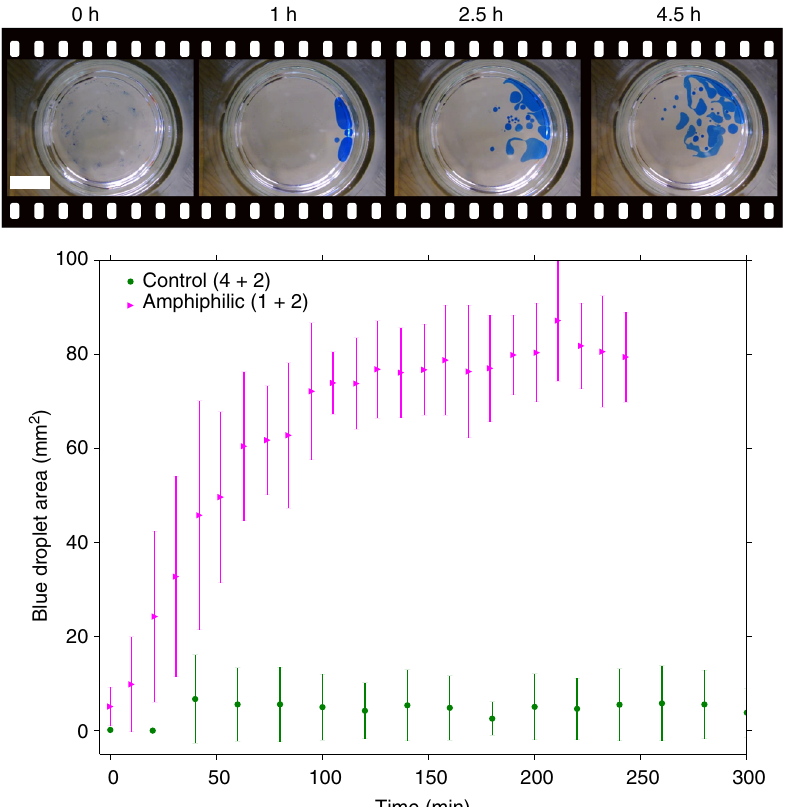
Fig. 5 Periodic droplet experiment results. Plot of droplet area vs. reaction time, for the self-replicating amphiphile forming reaction starting from 10 mM hydrophobic amine 1 with 10 mM 4-formyl(phenyl) acetic acid 2 ( magenta ) and for the control reaction starting from 10 mM unmodi fi ed amine 4 and 10 mM 4-formyl(phenyl) acetic acid 2 . Points are the mean value obtained from three repeats, and the error bars show the standard deviation. Above the graph are images taken 120 s after droplet placement from a mixture that had been allowed to react for 0, 1, 2.5 and 4 h respectively ( scale bar length is 10